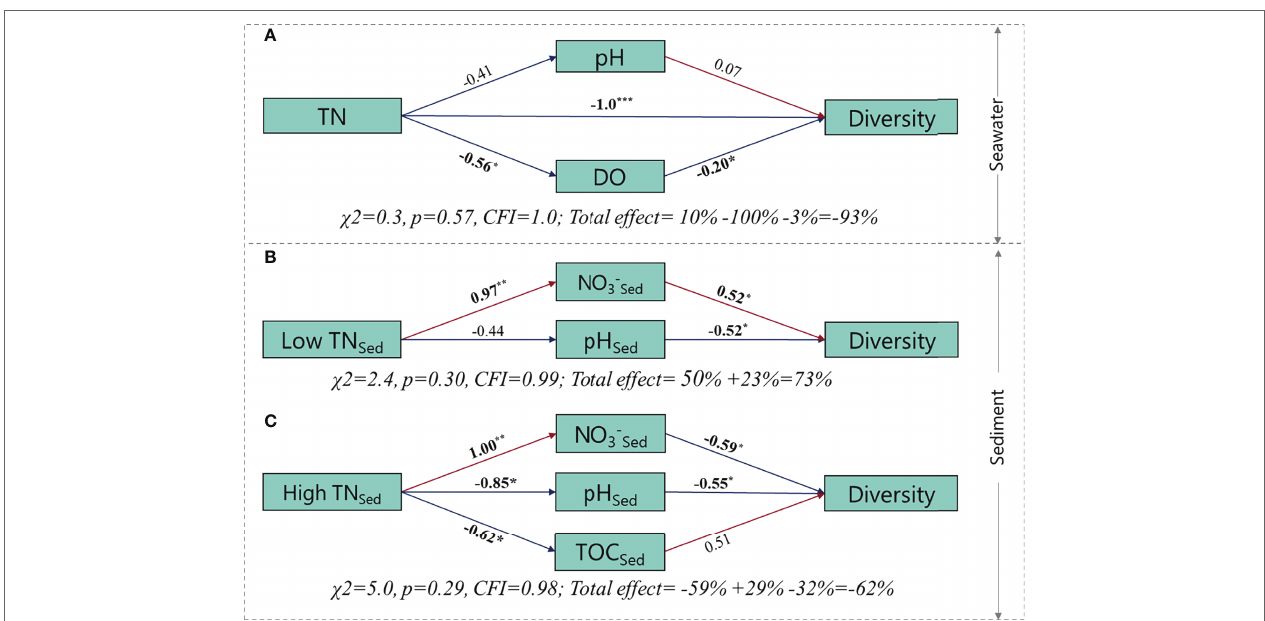
FIGURE 5 | Structural equation modeling depicting the changes of microbial diversity caused by nitrogen loading. Single-headed arrows represent unidirectional causal relationships. The numbers adjacent to the arrows are standardized path coefficients (significant correlations are shown in bold, *p < 0.05, **p < 0.01). The red and blue lines represent significant positive and negative pathways,